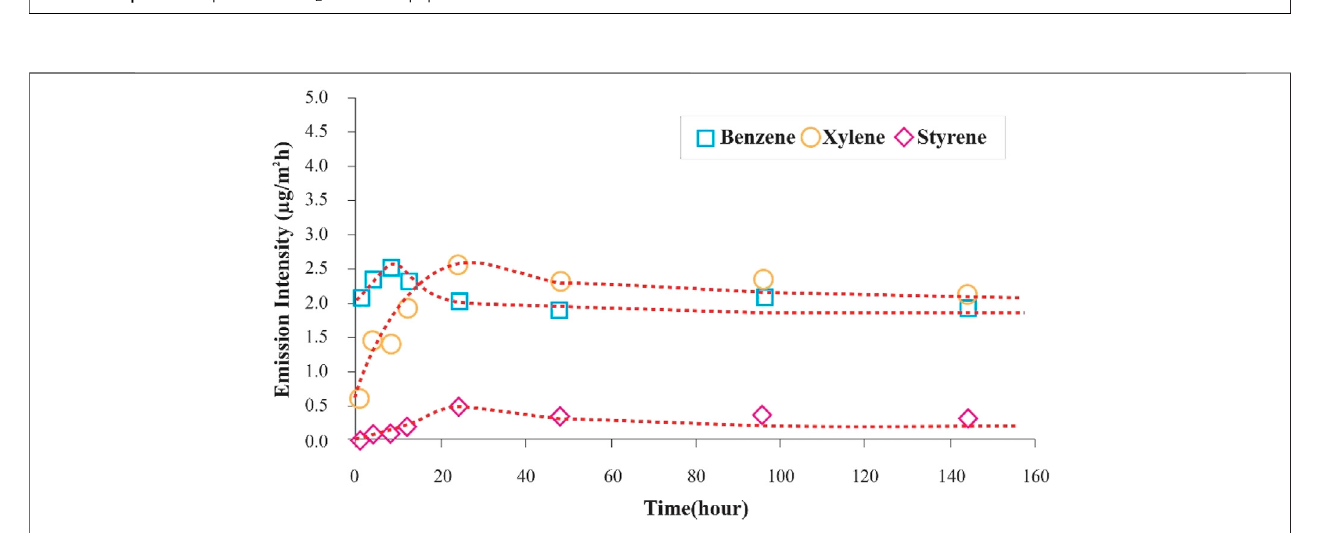
FIGURE 7 | Emission pattern of benzene, xylene, and styrene from fl ooring.